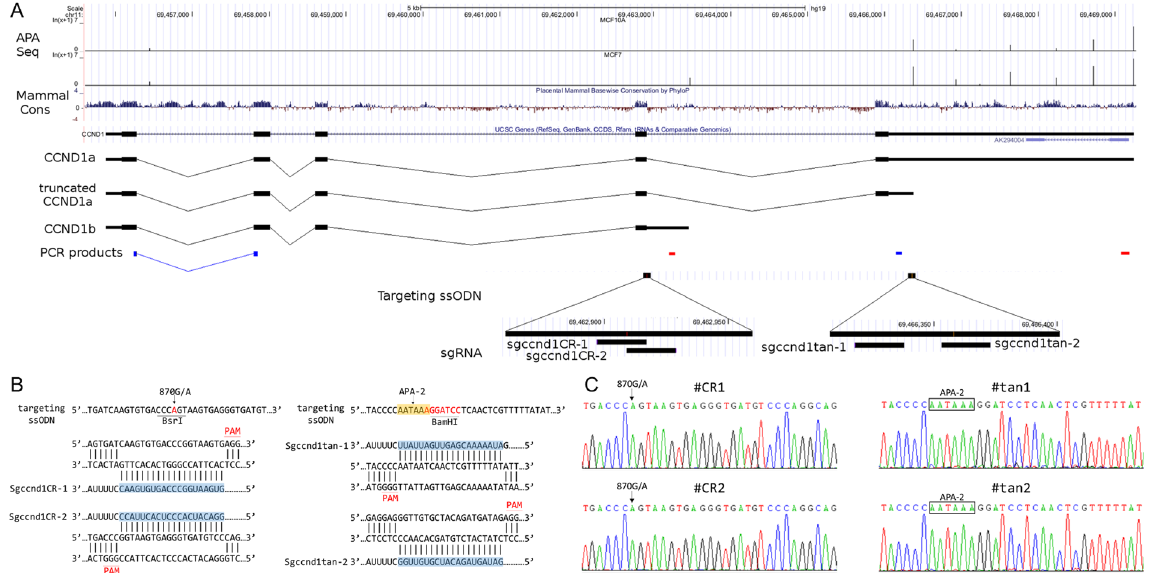
Figure 1. Alternative polyadenylation of CCND1 and PAS editing with CRISPR/Cas9. ( A ) Upper panel: APA switching in breast cancer cell lines. MCF10A is a human normal mammary epithelial cell line; MCF7 is a human breast cancer cell line. Lower panel: Schematic representation of the CCND1 locus, APA sites, mRNA isoforms, sgRNA and ssODN. qRT-PCR products used to quantify usage of the APA sites are also shown; the first two correspond to the APA-1 site (CR-APA) and the last two are for the APA-2 site (UTR-APA). Blue represents the common region and red represents the extended region. ( B ) Sequences of the single-stranded oligonucleotides (ssODN) and sgRNAs used to target the locus. Two sgRNAs were designed for each APA site. Left panel (870 G/A for APA-1): “G” at position 870 is replaced by “A”, which introduces a BsrI site “CCCAGT”; Right panel (APA-2): “AGGATCC” was inserted following “AATAA” at position 304 bp upstream of the stop codon, introducing a canonical PAS “AATAAA” site and a BamHI site. ( C ) Sequencing validation of the mutated cell lines. #CR1 and #CR2 clones were mutated to use the APA-1 site with sgccnd1CR-1 and sgccnd1CR-2, respectively. #tan1 and #tan2 clones were mutated to use the APA-2 site with sgccnd1tan-1 and sgccnd1tan-2,